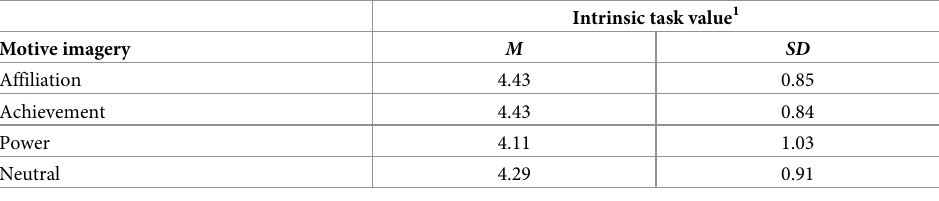
Table 8. Means and standard deviations for the intrinsic task values for neutral tasks and tasks related to affilia- tion, achievement, and power (pooled data from Experiments 1 and